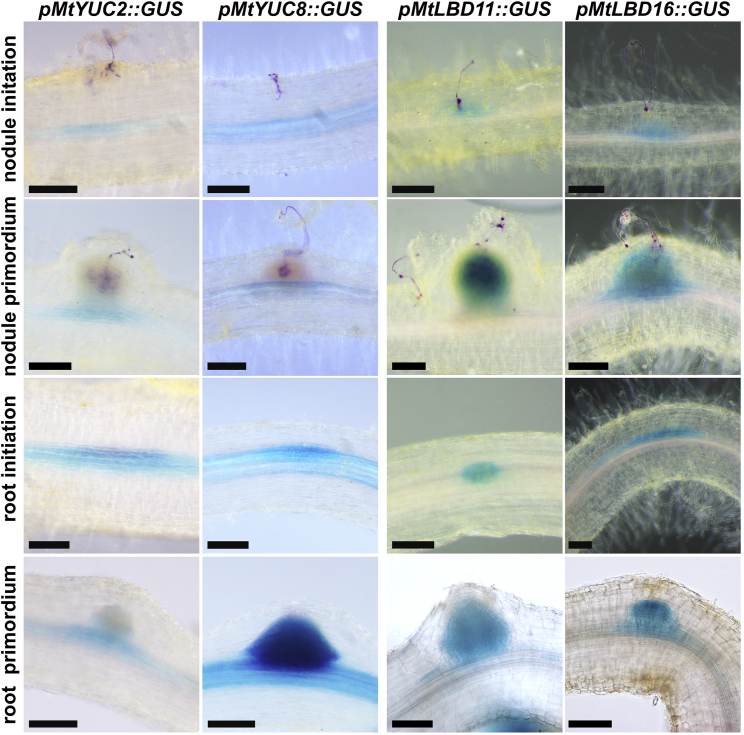
LATERAL ORGAN BOUNDARIES and YUCCAs Are Expressed during Root and Nodule Primordium Initiation and DevelopmentExpression patterns of YUC2, YUC8, LBD11, and LBD16 during nodule and lateral root development visualized by GUS staining (blue). Rhizobial-expressed LacZ is stained magenta. Scale bars: 100 μm.See also Figure S3 and Data S2A and S2B.